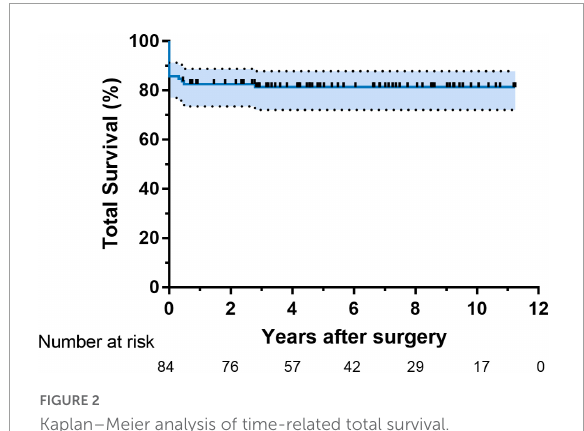
FIGURE2 Kaplan–Meier analysis of time-related total survival.